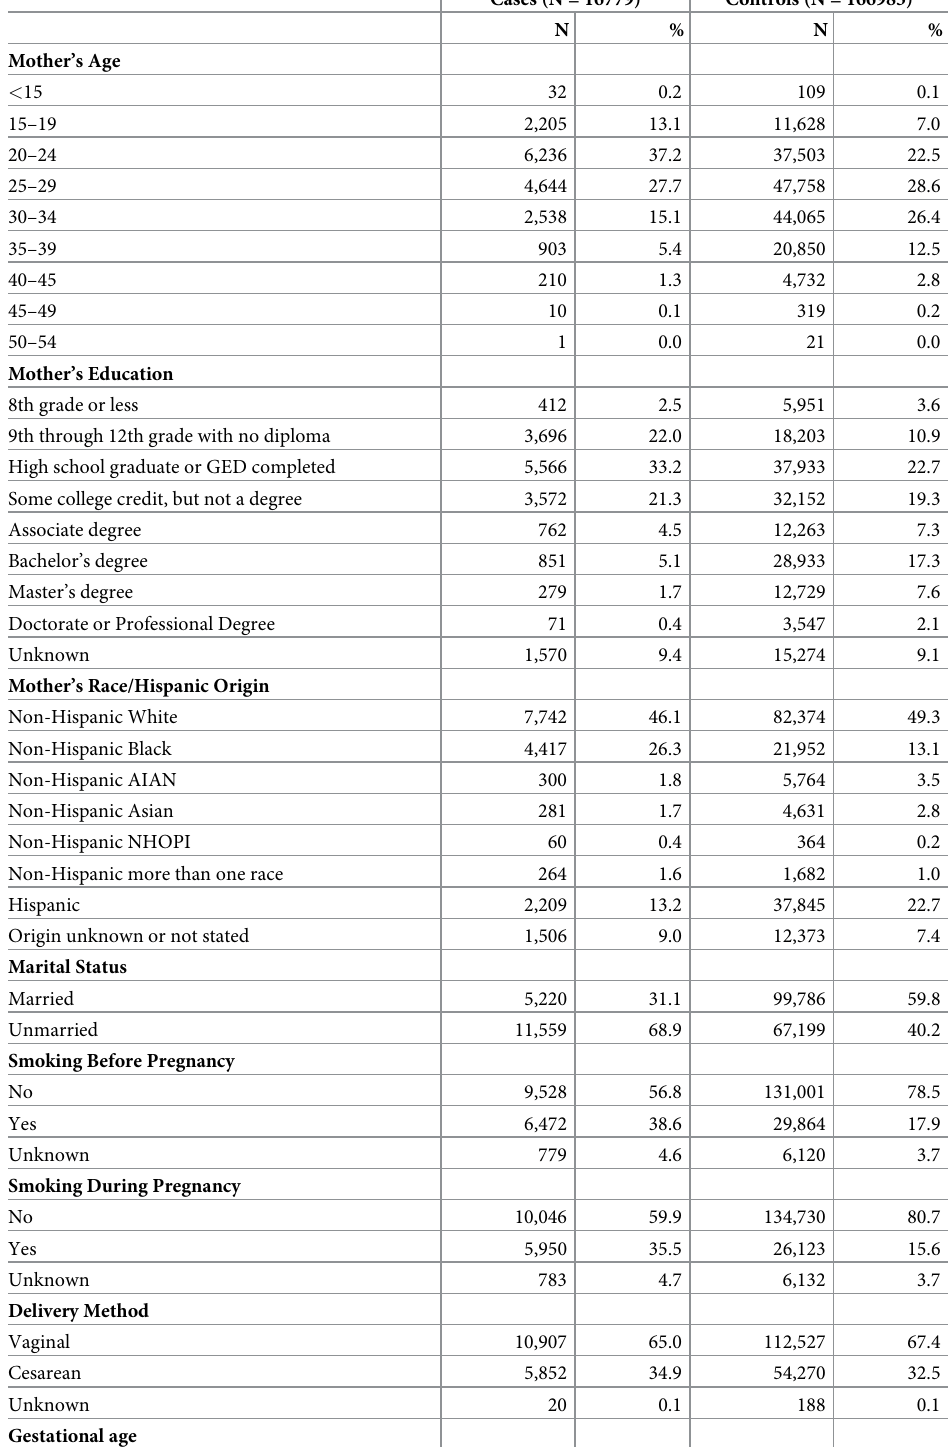
Table 1. The study population: 16,779 SUID cases and 166,985 controls, which were randomly sampled so that there were approximately 10 controls for each SUID case). Controls were infants that survived to first